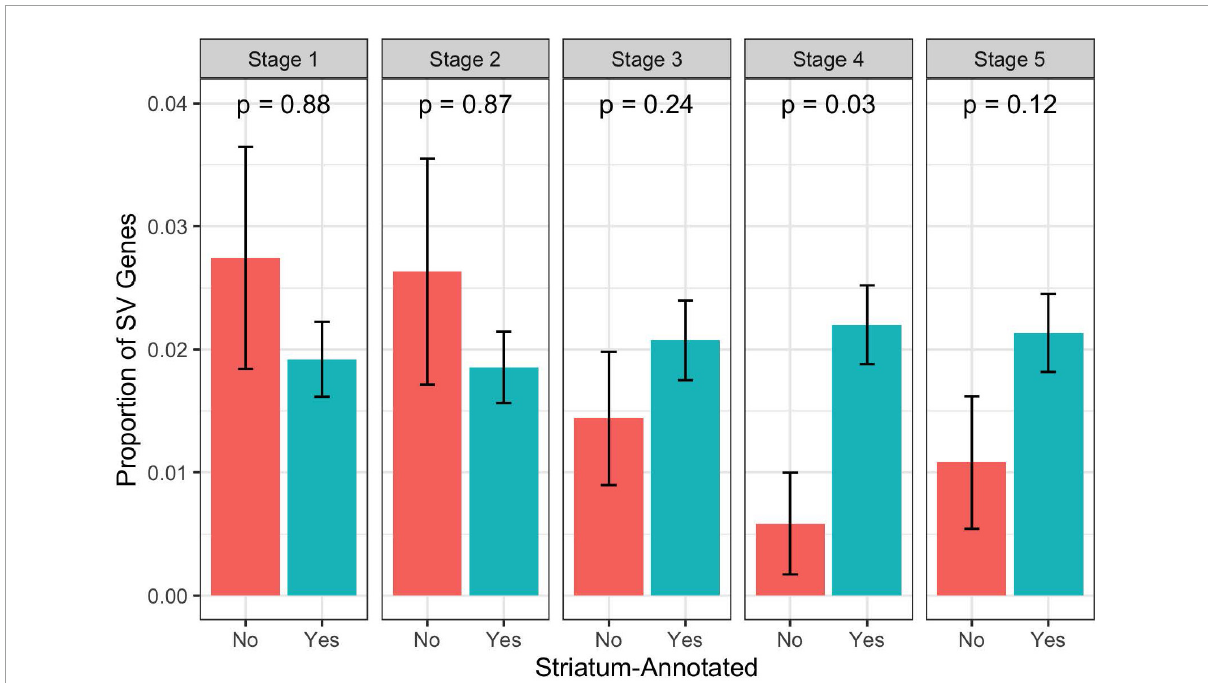
FIGURE6 Proportion of brain expressed case-specific SV genes annotated to the striatum-expressed gene set vs non-striatum-expressed gene set across development. P -values are from a hypergeometric test for over-representation of case-specific SV genes in the striatum-annotated gene set. Note that these are not the competitive p -values as calculated by ABAEnrichment through permutation. Stage 1 = Prenatal, Stage 2 = Infant, Stage 3 = Child, Stage 4 = Adolescent, Stage 5 =